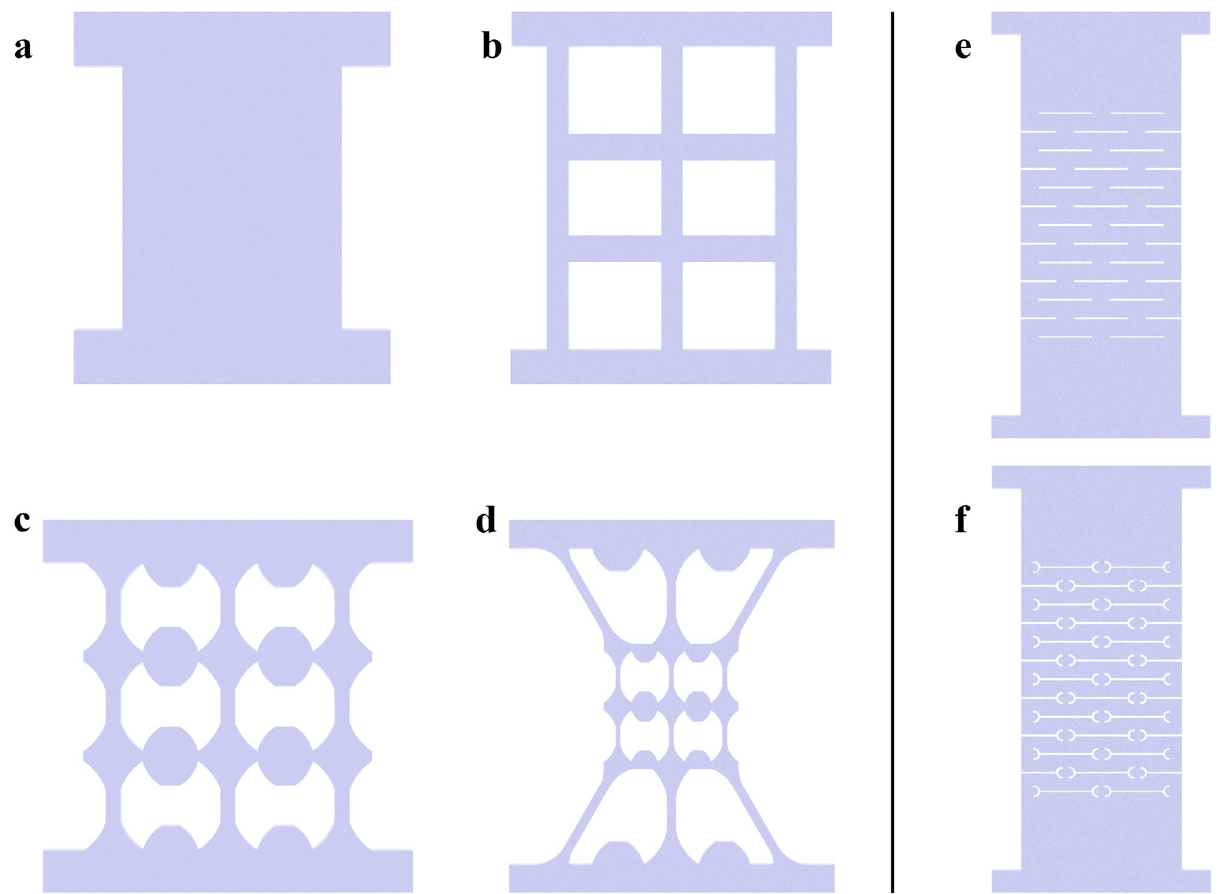
Figure 1. Different topological designs. ( a ) Non-patterned, ( b ) Grid, ( c ) Dog-Bone Grid, ( d ) Hierarchical Dog- Bone, ( e ) Kirigami, and ( f ) Modified Kirigami